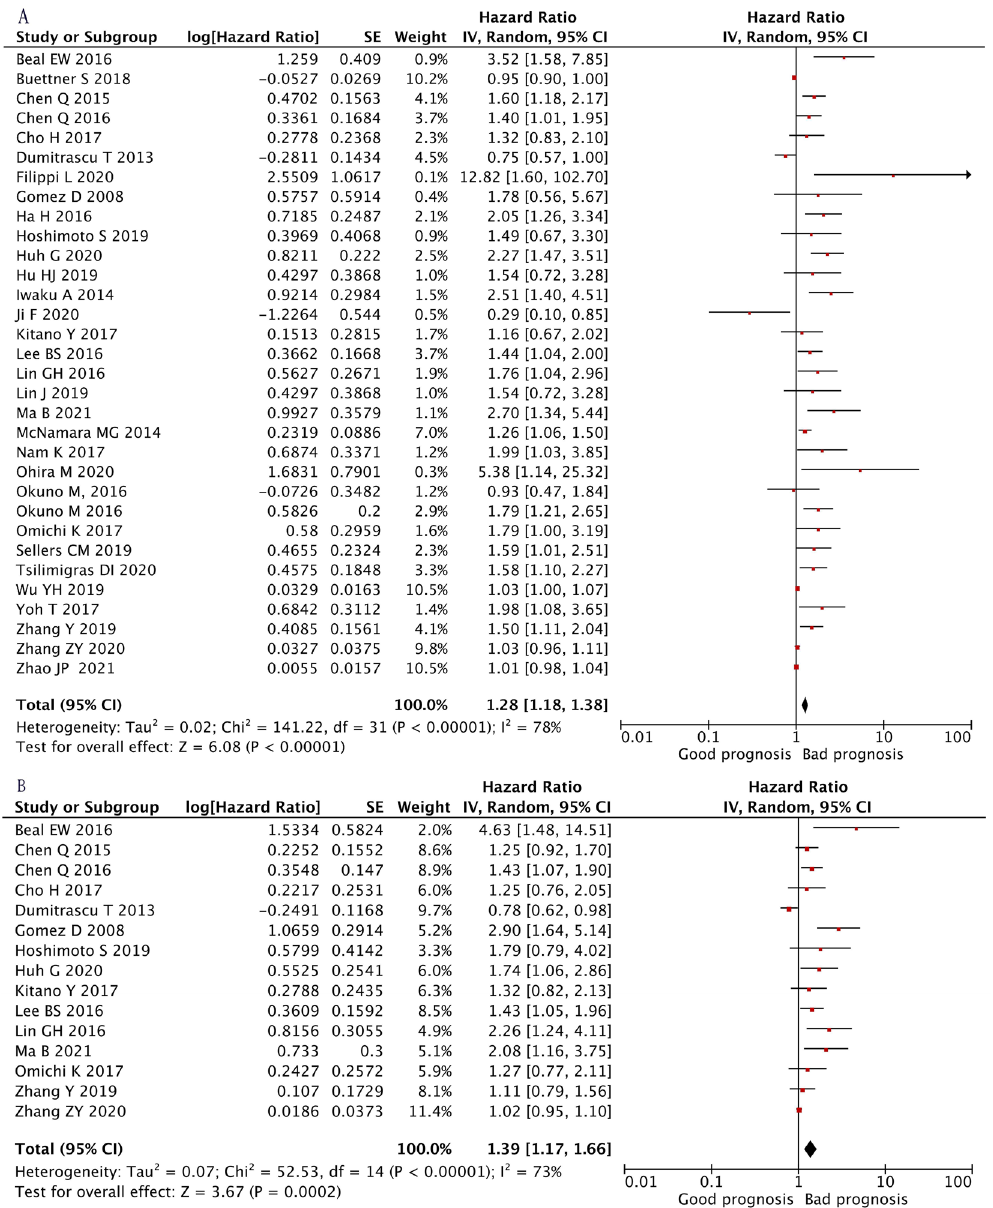
Figure 2. Forest plot of the correlation between NLR and survival in CCA. High NLR values indicated a worse OS ( A ) (HR 1.28, 95% CI 1.18–1.38, p < 0.01) with high heterogeneity (Tau 2 = 0.02, Chi 2 = 141.22 p < 0.01, I 2 = 78%) and a higher NLR level was associated with worse DFS ( B ) (HR 1.39, 95% CI 1.17–1.66, p < 0.01) with high heterogeneity (Tau 2 = 0.07, Chi 2 = 52.53 p < 0.01, I 2 =